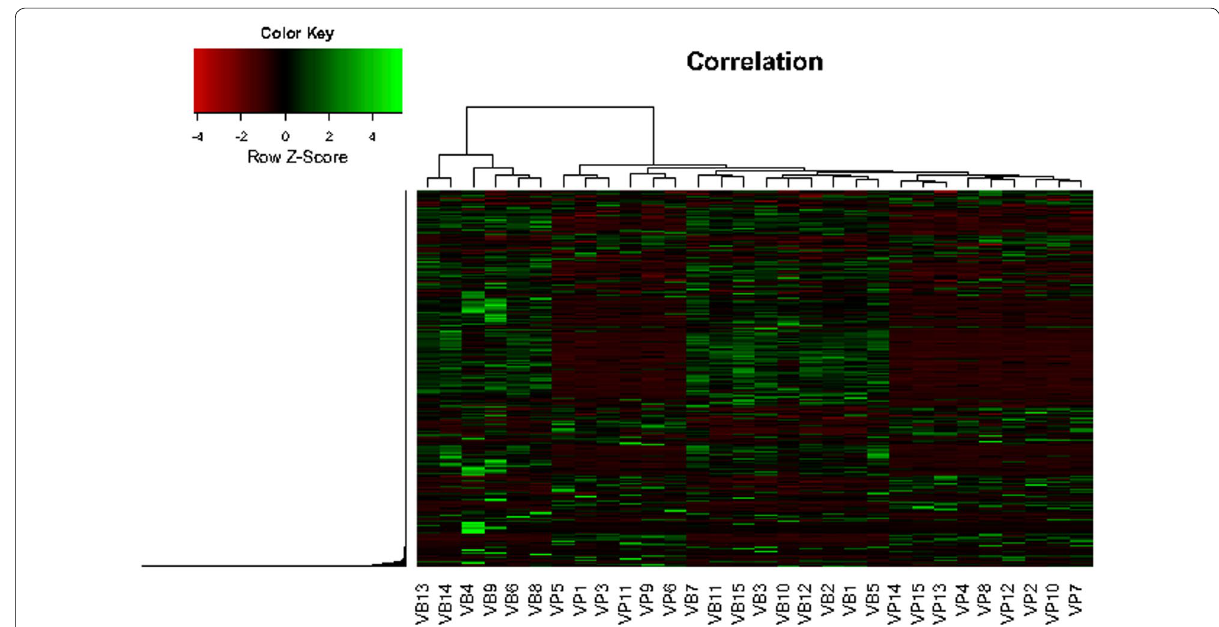
Fig. 5 Heat map of cluster for vanilla pods and vanilla